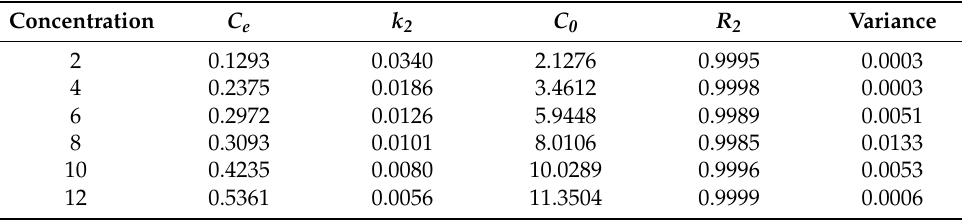
Table 10. Estimated parameter values of the PSO models by the numerical calculations for the extraction process at different dye